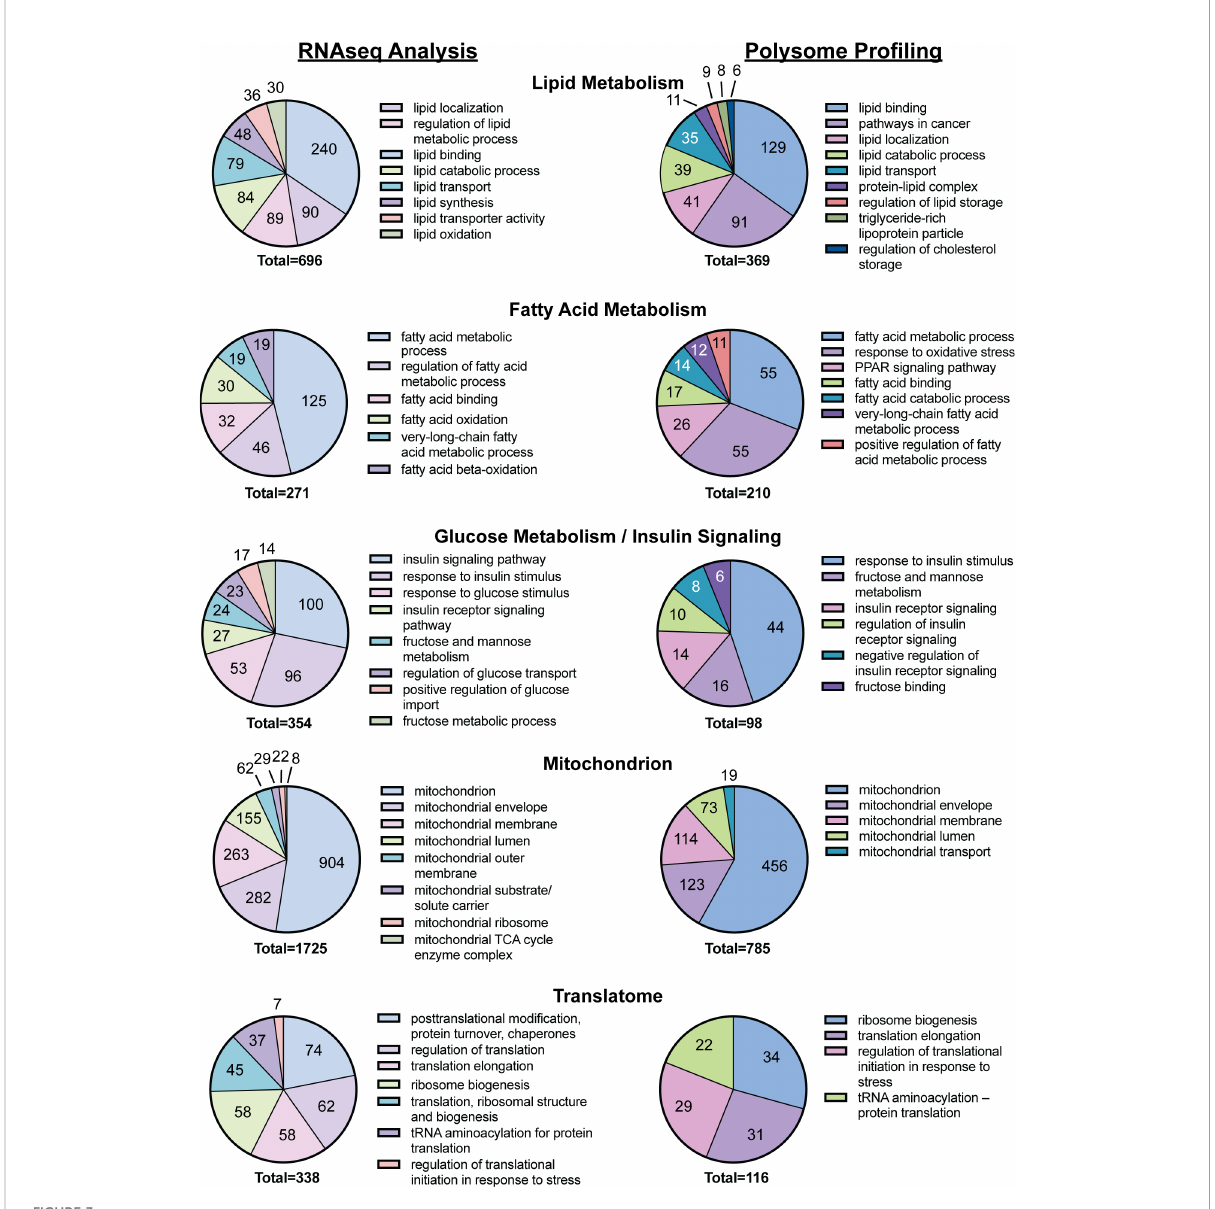
FIGURE 3 DAVID analysis of the results of the RNAseq and polysome pro fi ling, i.e., Riboseq, analyses from Figure